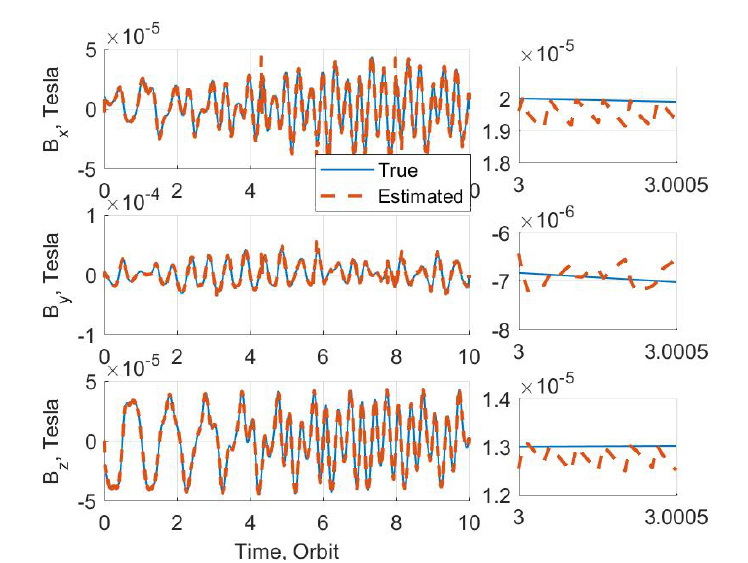
Figure 8. Ambient magnetic field history over